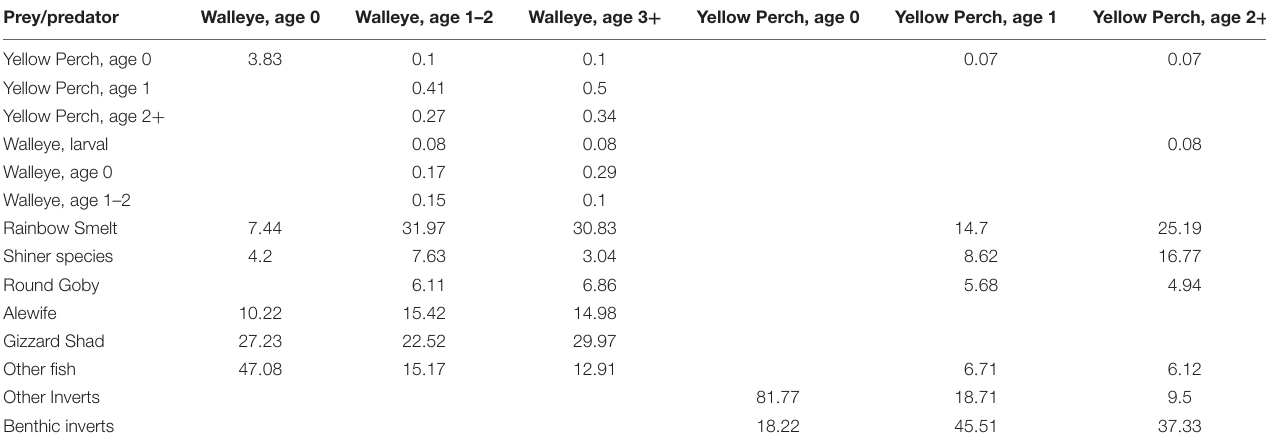
TABLE 2 | Percent of total diet for Yellow Perch and Walleye in the balanced Ecopath model. Prey/predator Walleye, age 0 Walleye, age 1–2 Walleye, age 3 + Yellow Perch, age 0 Yellow Perch, age 1 Yellow Perch, age 2